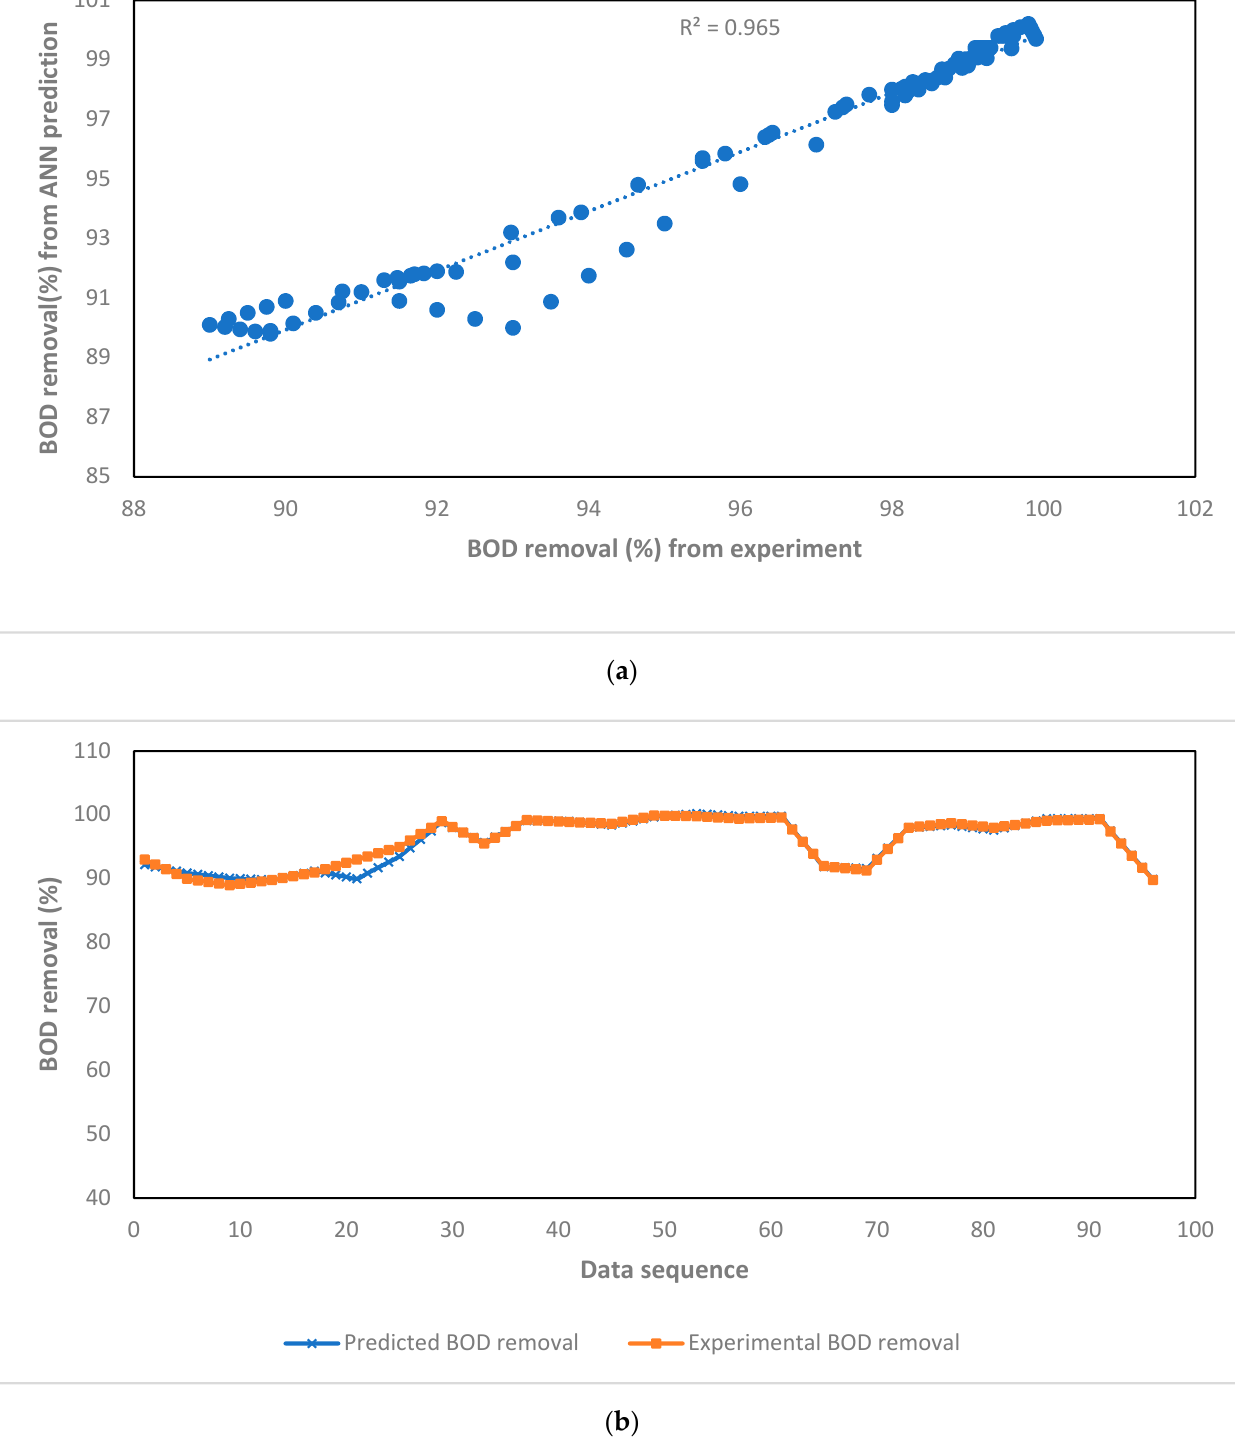
Figure 7. ( a ) Correlation between experimental data and predicted value of BOD removal. ( b ) Prediction value and measured data by ANN model for BOD removal (aerobic process). High R 2 value and minimal deviation between the predicted TSS removal and experimental TSS removal was observed in Figure 8 respectively. While all three R 2 values for COD, BOD and TSS removals are more than 0.9, this shows that ANN model can be used to predict the output parameters accurately.